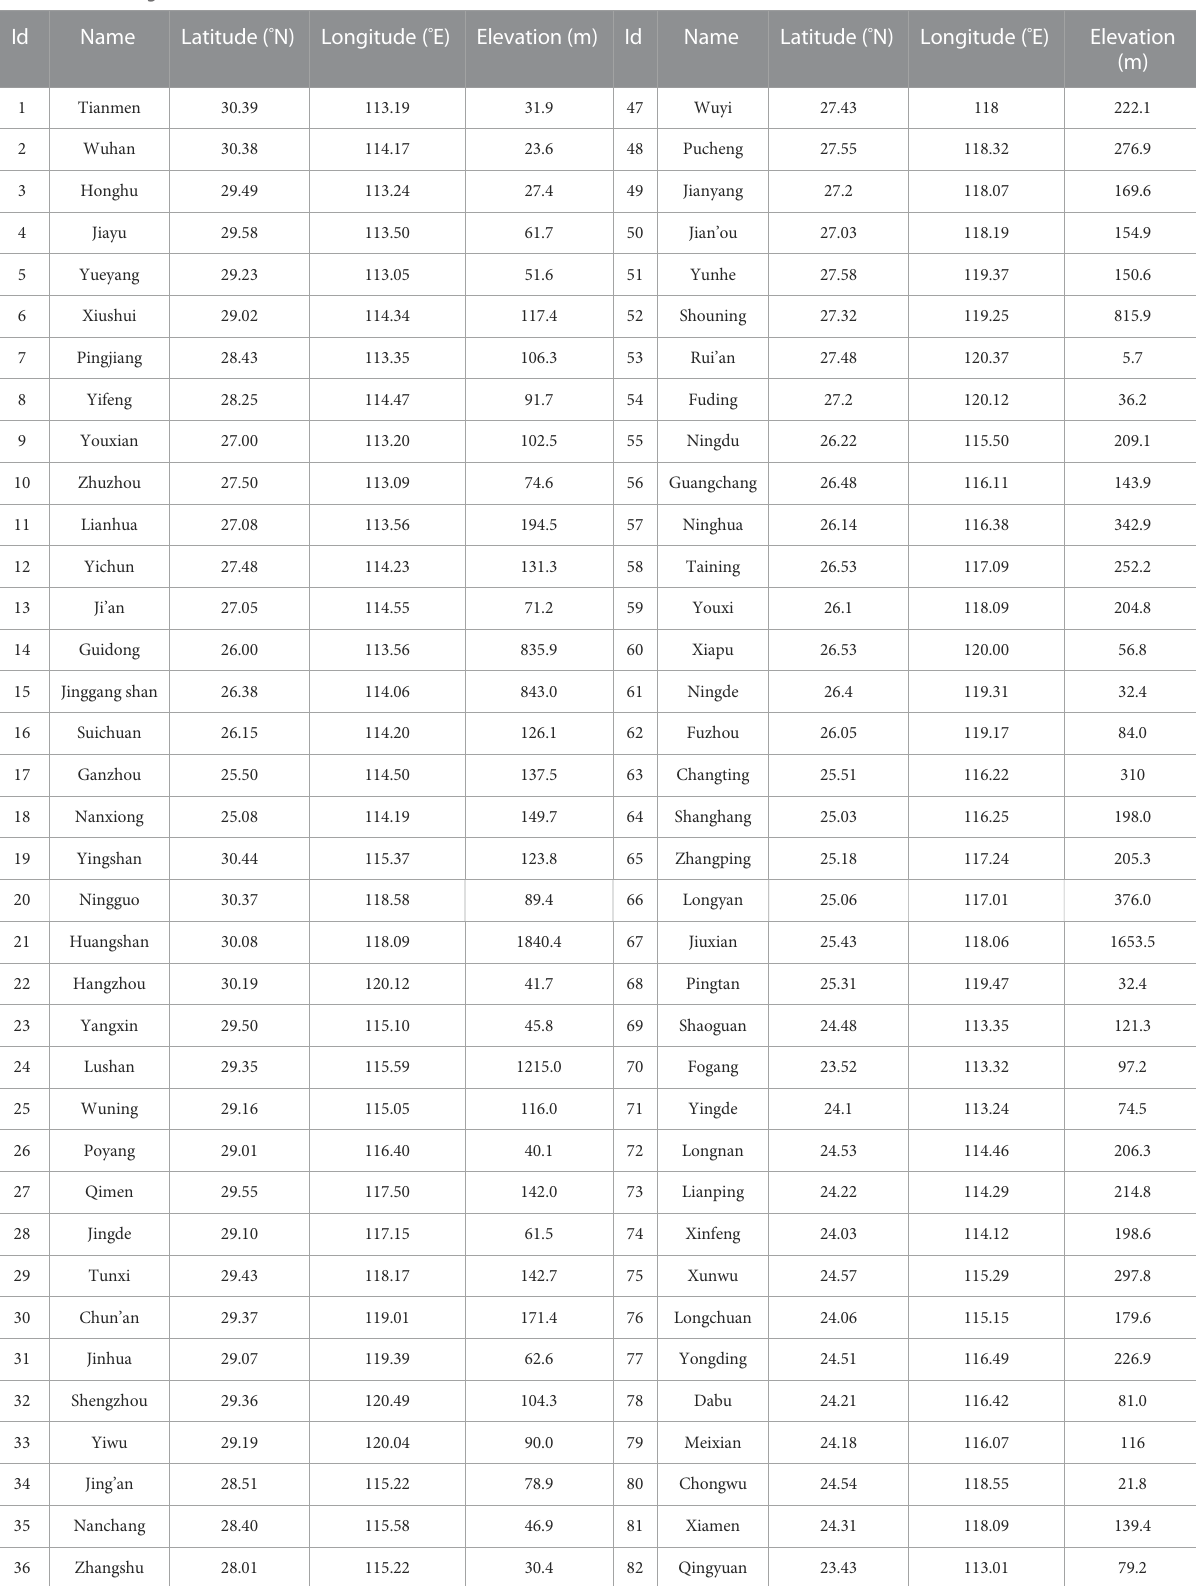
TABLE 1 Meteorological stations